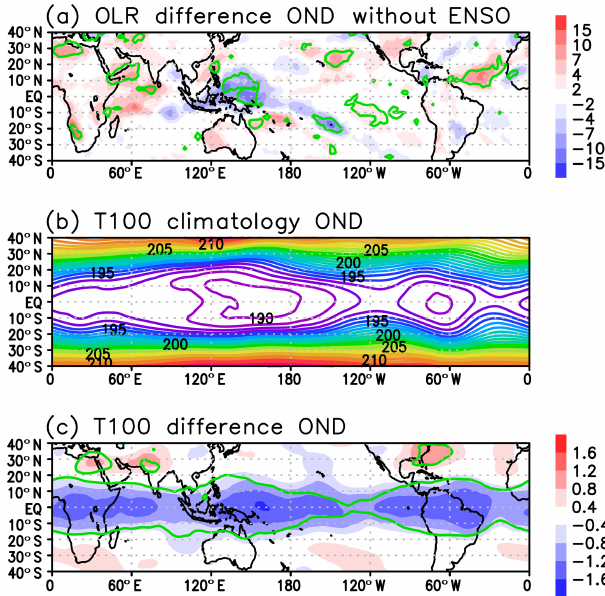
Figure 4. Same as Fig. 3 but without ENSO